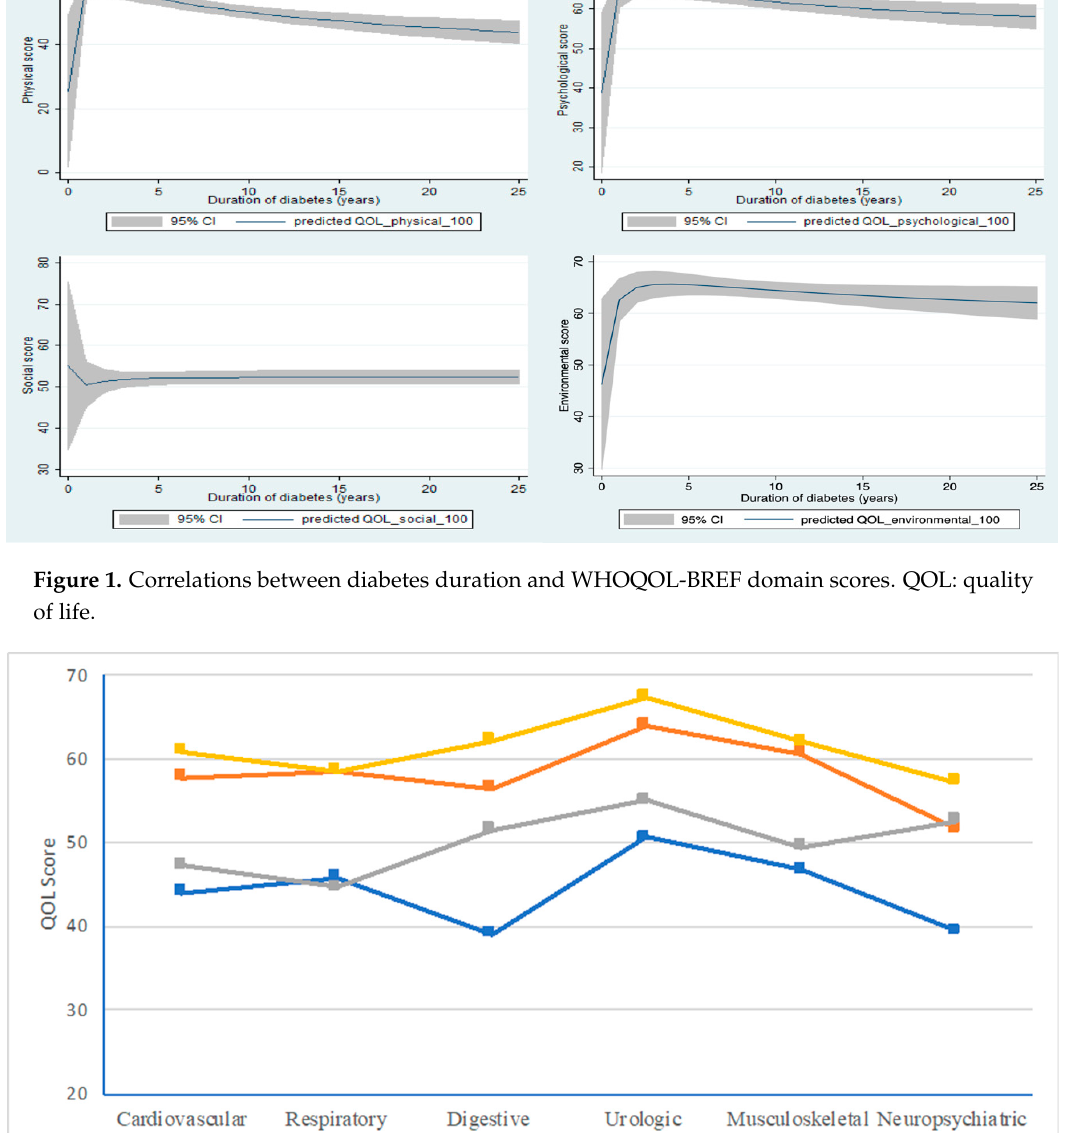
Figure 2. WHOQOL-BREF domain scores of respondents with health problems.